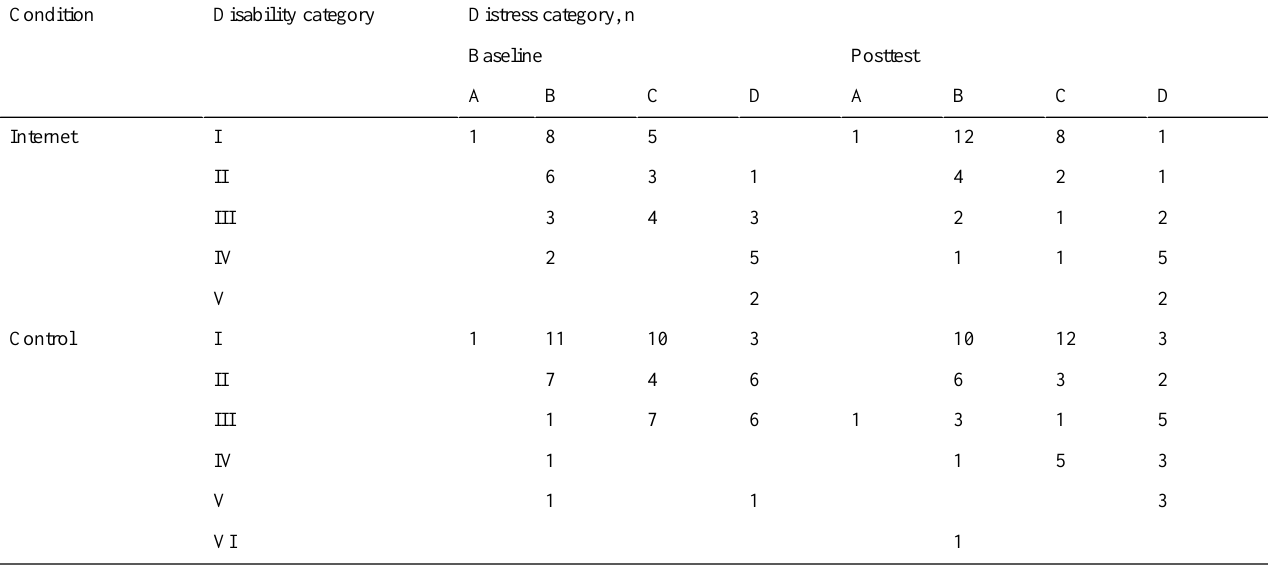
Table 4. Descriptive matrix with number of participants for each disability and distress state, for condition and test